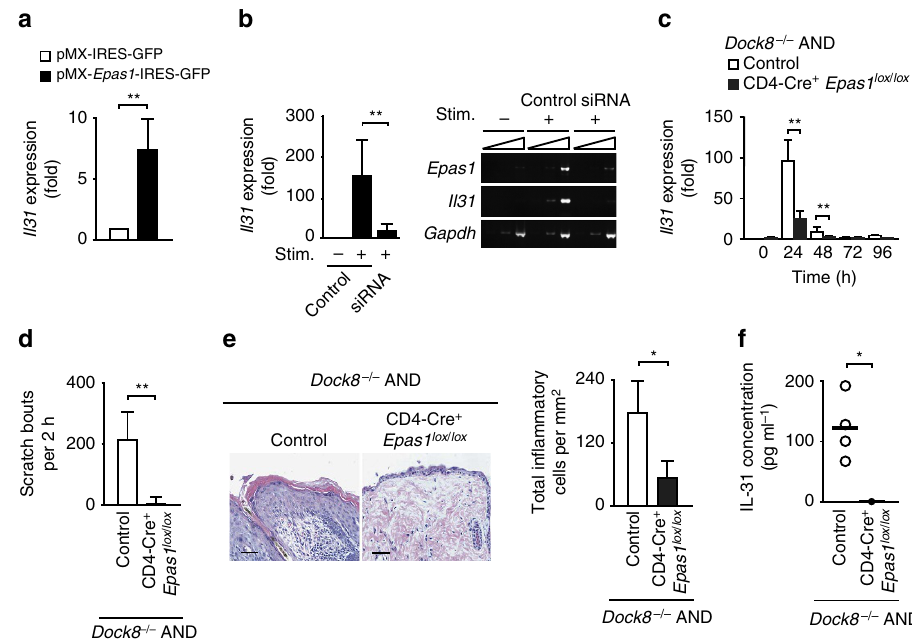
Figure 4 | EPAS1 acts as a regulator for IL-31 induction during skin inflammation. ( a ) Induction of Il31 gene expression in WT CD4 þ T cells by overexpression of EPAS1. Expression (fold increase) is relative to that of the control vector (pMX-IRES-GFP). Data are expressed as mean ± s.d. of eight samples per group. ** P o 0.01 (two-tailed Mann–Whitney test). ( b ) Effect of Epas1 knock down on Il31 gene expression in CD4 þ Tcells from Dock8 (cid:2) / (cid:2) AND Tg mice. Expression (fold increase) is relative to that of the unstimulated samples. Data are expressed as mean ± s.d. of 6 samples per group. ( c ) Effect of genetic inactivation of Epas1 on Il31 gene expression in CD4 þ Tcells from Dock8 (cid:2) / (cid:2) AND Tg mice after primary stimulation